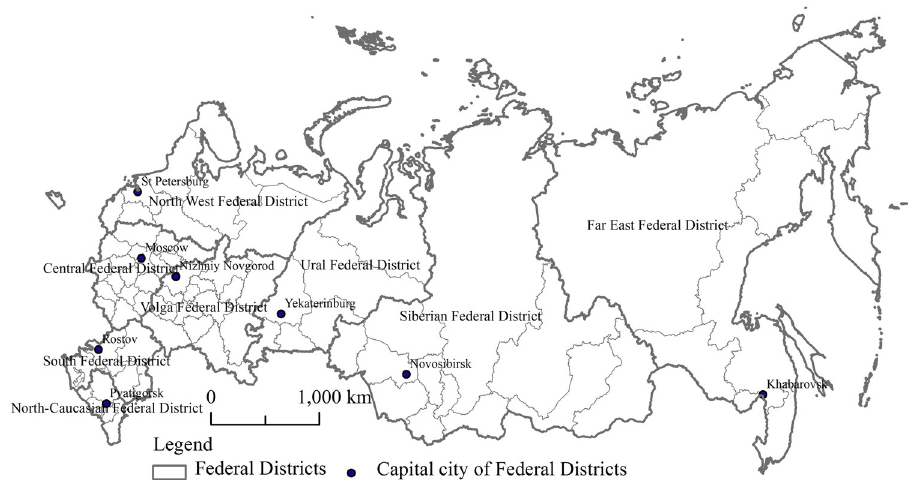
Fig 1. Sketch map of the study area of the Russian